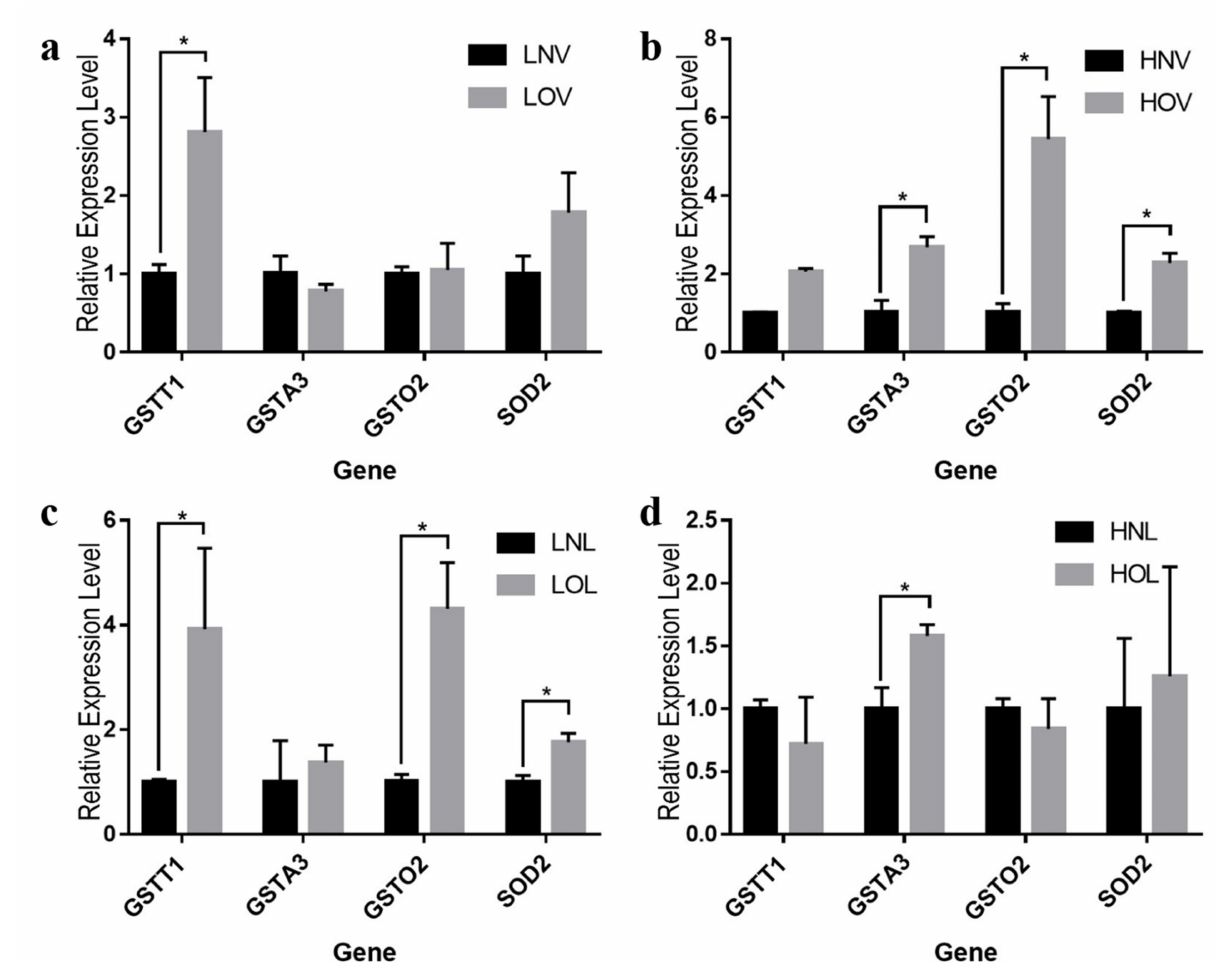
Figure 2. Effects of different dietary qualities on gene expression of GSTT1 , GSTA3 , GSTO2 and SOD2 of livers. The abscissa indicates the gene name; and the ordinate value is normalized to β -actin and NAPDH , results are expressed as 2 − ∆∆ Ct ( n = 24). LNV = low-dose normal vegetable oil, HNV = high-dose normal vegetable oil, LNL = low-dose normal lard, HNL = high-dose normal lard, LOV = low-dose oxidized vegetable oil, HOV = high-dose oxidized vegetable oil, LOL = low-dose oxidized lard, HOL = high-dose oxidized lard. * p <